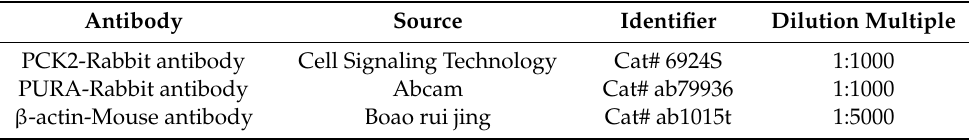
Table 3. Information and dilution multiple of antibodies.